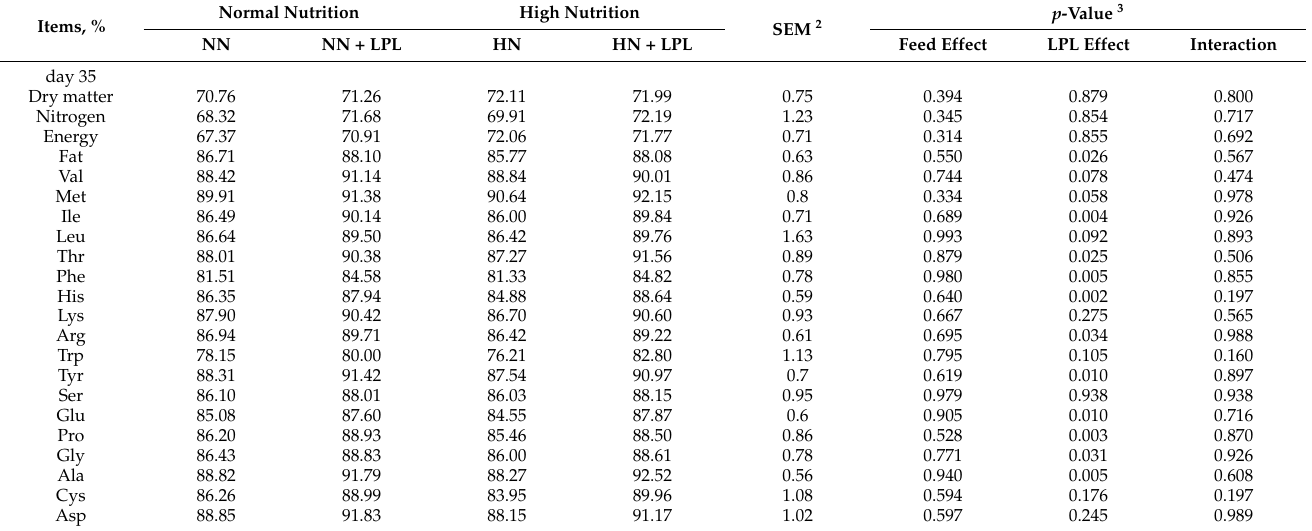
Table 4. Effect of LPL supplementation in diet with different nutrition content on ileal digestibility in broilers 1